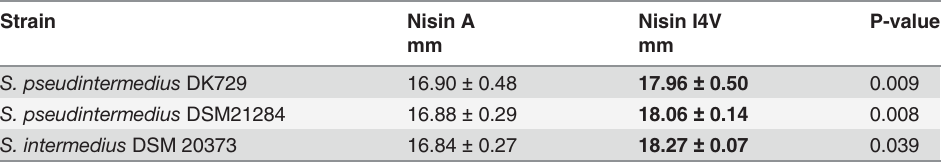
Table 2. Deferred antagonism assays of L. lactis NZ9800 strains producing nisin A (wild type control) and the nisin derivative I4V against representative strains of S. pseudintermedius and S. intermedius .